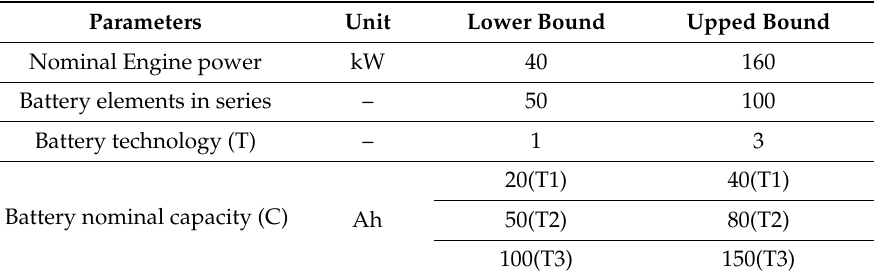
Table 4. Design variables defining the size and technology of the